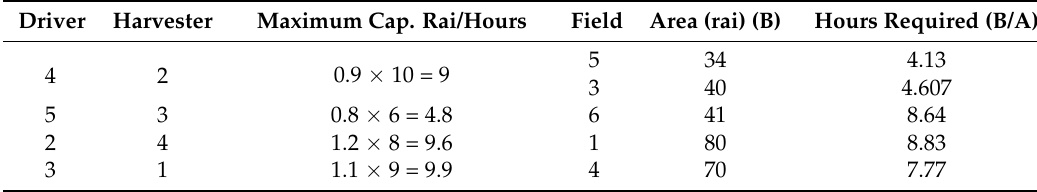
Table 4. Results from the assignment process.